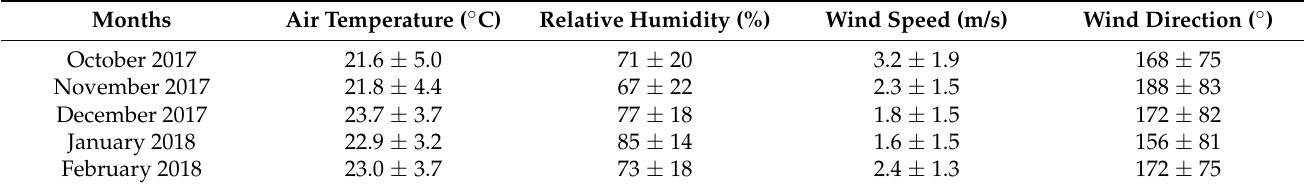
Table 1. Average values (mean ± SD) of the external meteorological variables during the trial.